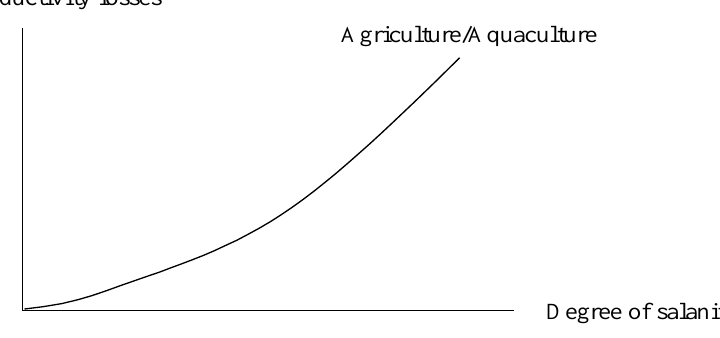
Figure 2. The damage salinity causes to agriculture and